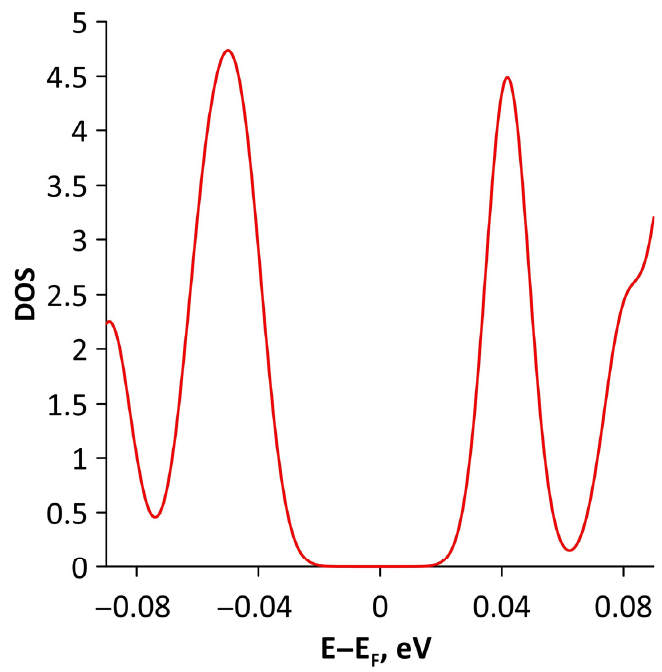
Figure 18. Fragment of DOS near the Fermi level (shifted to 0 eV) of borophene/GaN heterostructure under biaxial compression by 4%.